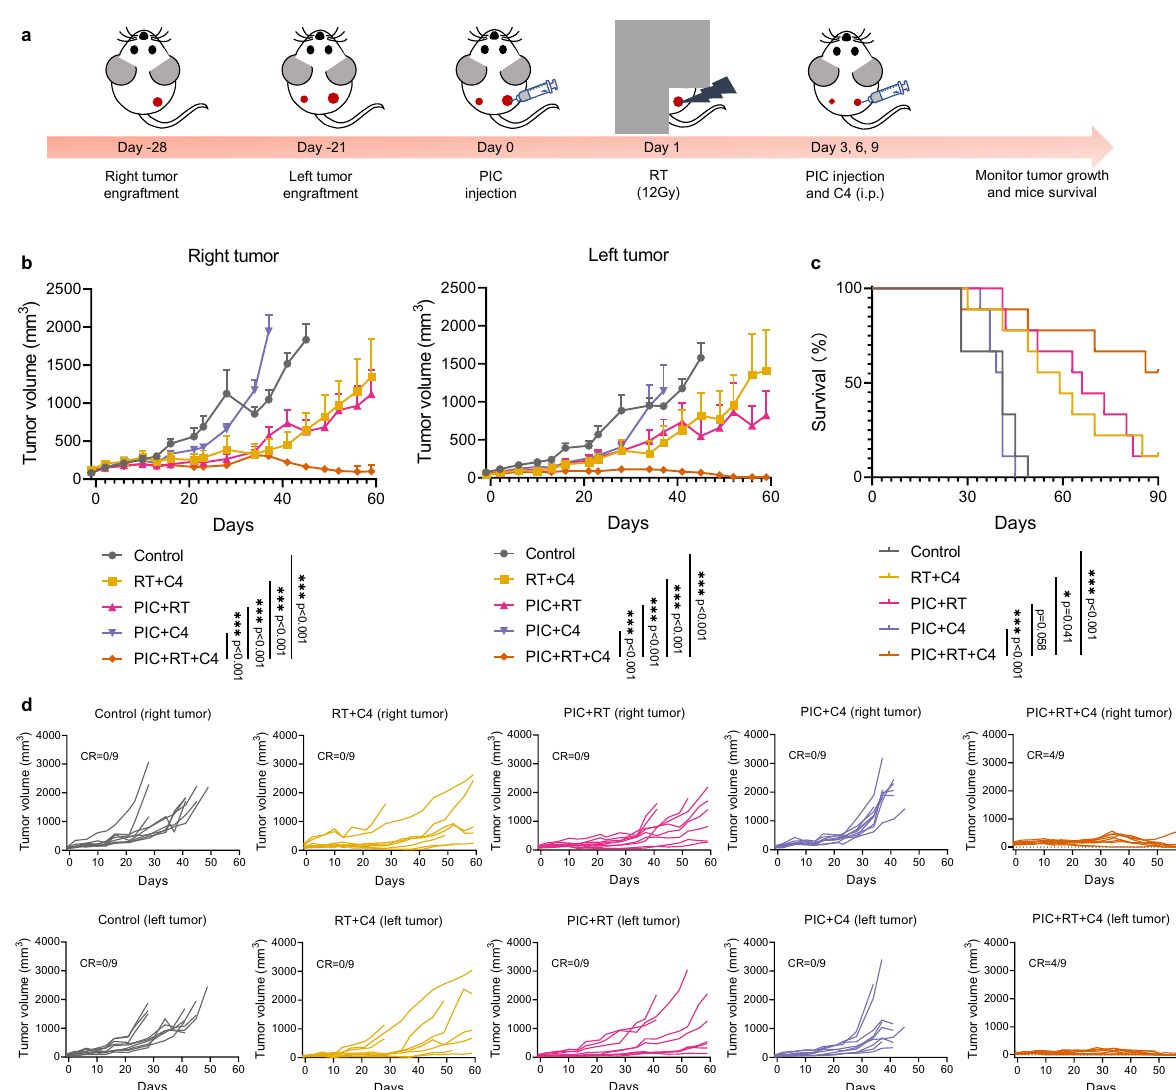
dose. Data in b are shown as mean±SD. The statistical signi fi cance was calculated via linear mixed effects modeling in b , and log-rank test in c . * p <0.05, ** p <0.01, *** p <0.001 and **** p <0.0001. We compared only the PIC+RT+C4 group